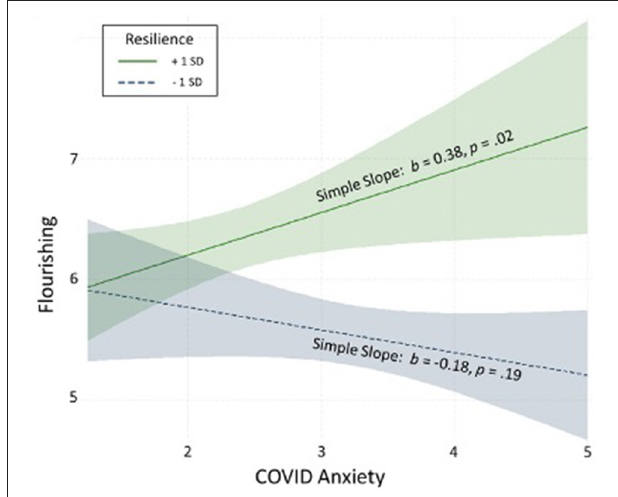
FIGURE 1 | Simple slopes decomposing the moderating effect of resilience on the association between COVID anxiety and